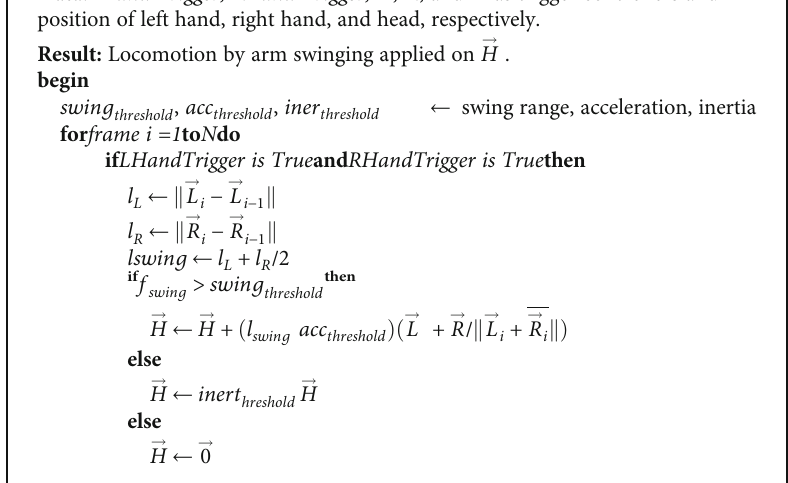
Algorithm 1: ArmSwing virtual